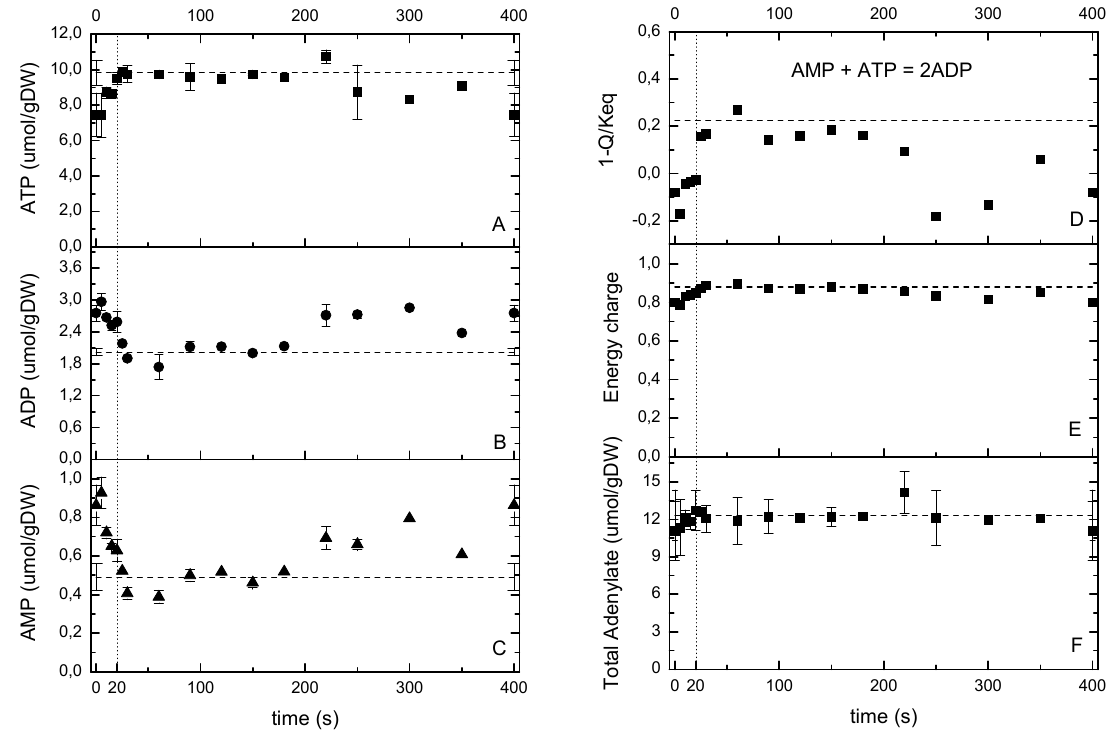
Figure 3. ( A – C ) ATP, ADP and AMP measurements during the cycle. ( D ) Thermodynamic driving force for adenylate kinase. ( E ) energy charge and ( F ) total adenylate pool over the cycle (right). The dashed line represents the reference measurement during the chemostat phase (D = 0.1 h − 1 ), error bars represent the standard error of duplicate determination during two subsequent cycles. The vertical dotted line represents the end of the feeding